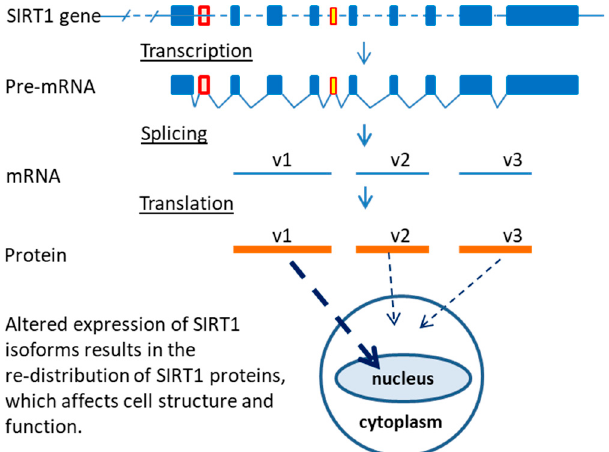
Figure 6. Schematic representation of the effect of alternative splicing on the localization of sirtuin isoform proteins. Human SIRT1-v1 isoform will be transported into the nucleus, whereas v2 and v3 isoform proteins will remain in cytoplasm. SIRT1-v1, v2, and v3 isoforms differentially regulate their target proteins and modulate cell structure and function, including mitochondrial function.